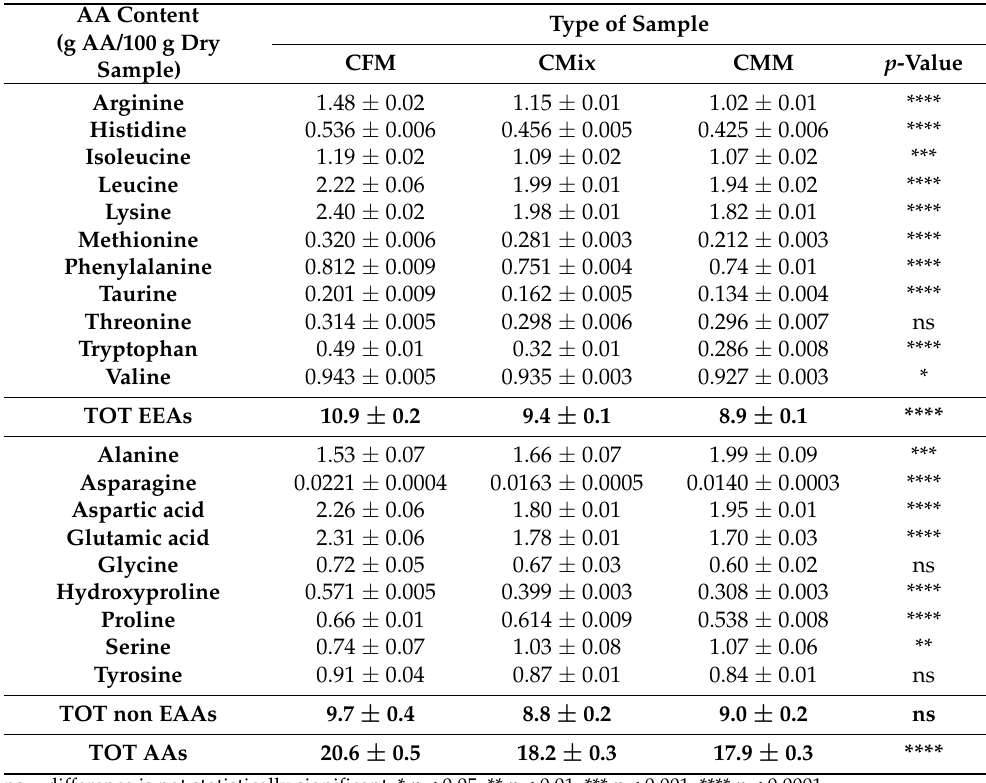
Table 2. AA content in CFM, CMix, and CMM formulation for companion animal food evaluated by Q-TOF LC/MS analysis. Data are reported as mean, n =